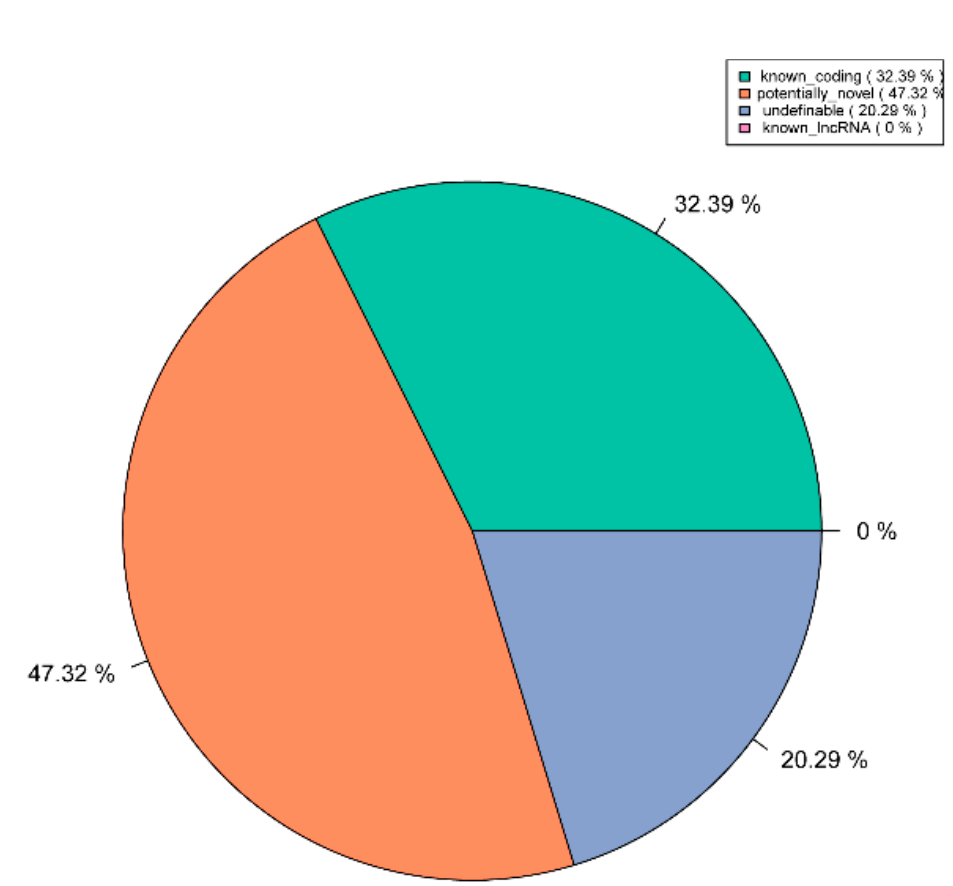
Figure A2. Classification of the novel